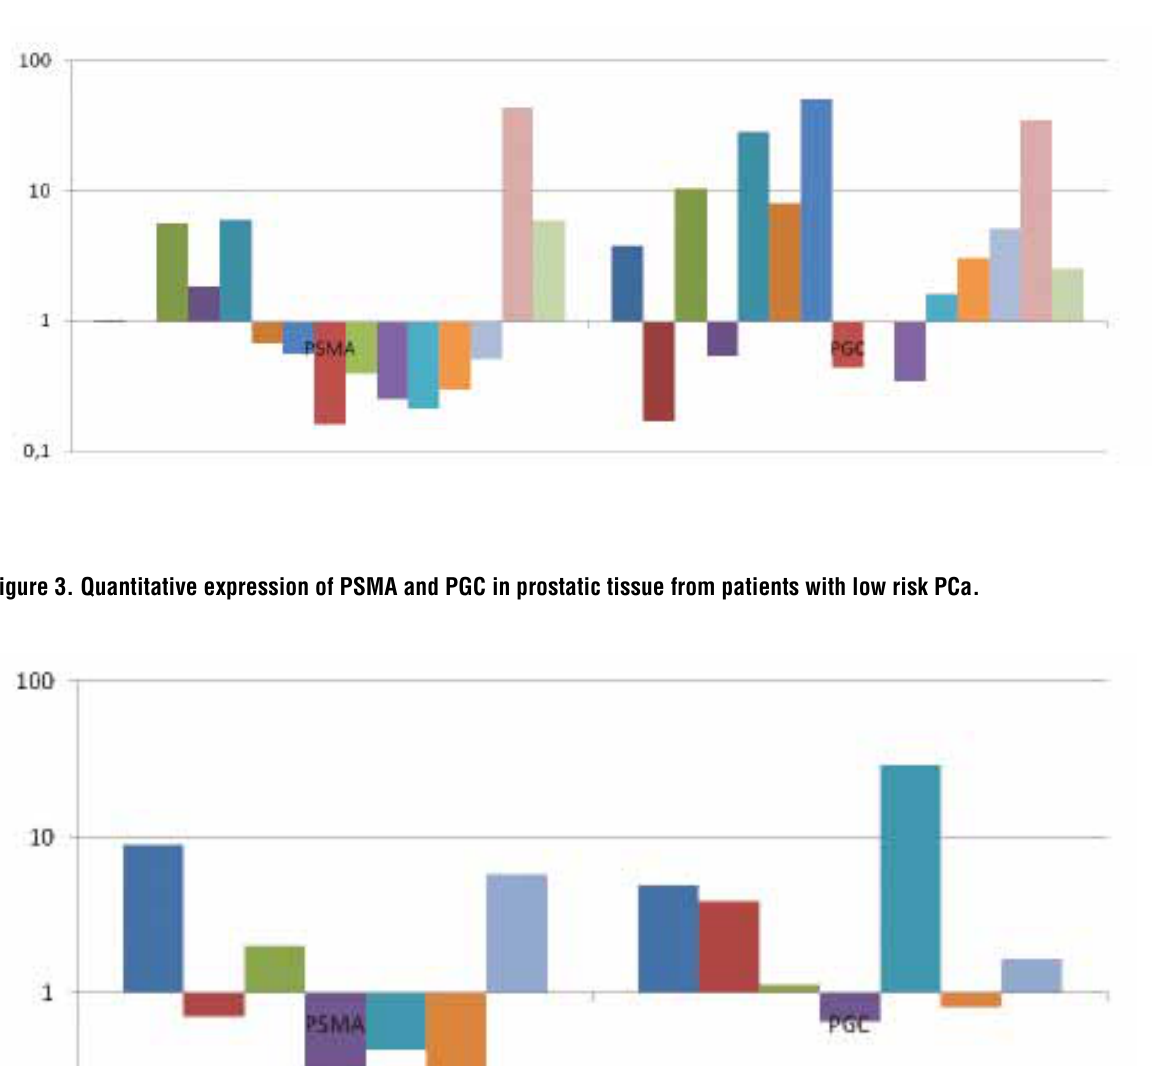
Figure 2. Quantitative expression of PsMA and PgC in biopsy samples from patients with high risk PCa.